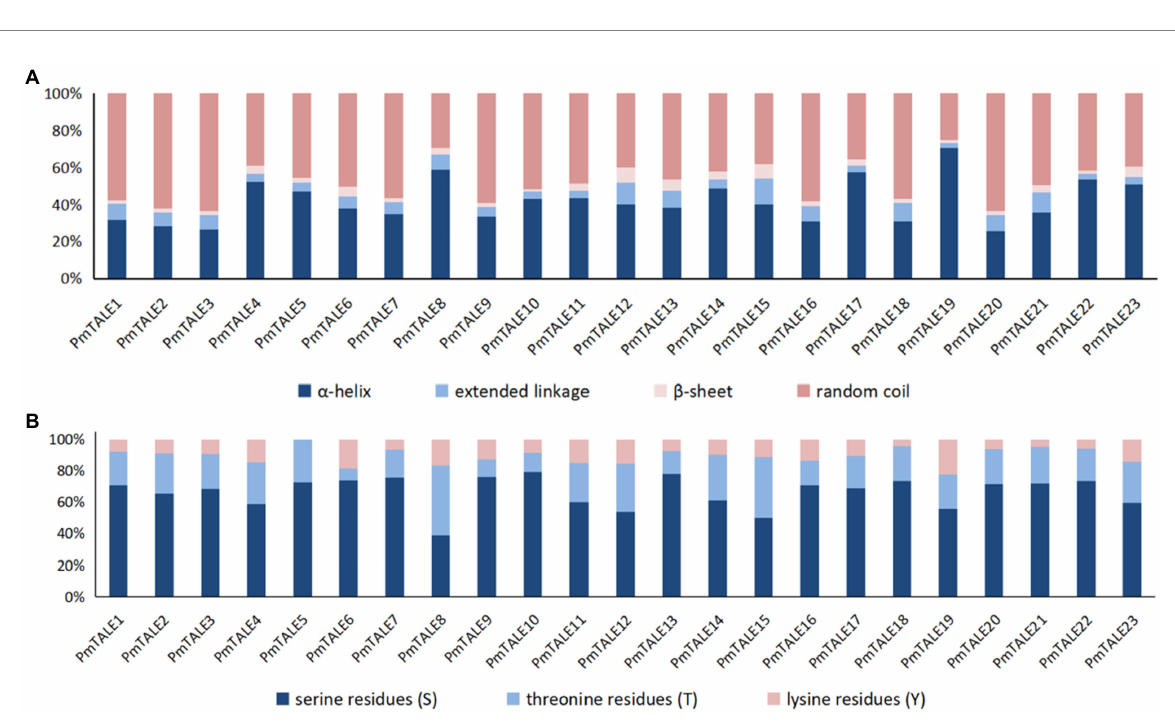
FIGURE 2 Analysis of protein secondary structure and phosphorylation site of Prunus mume TALE gene family members, (A) reflects the proportion of the four types of secondary structures of the TALE proteins; (B) reflects the proportion of the three types of phosphorylation sites of the TALE proteins. S, serine residues; T, threonine residues; and Y, lysine